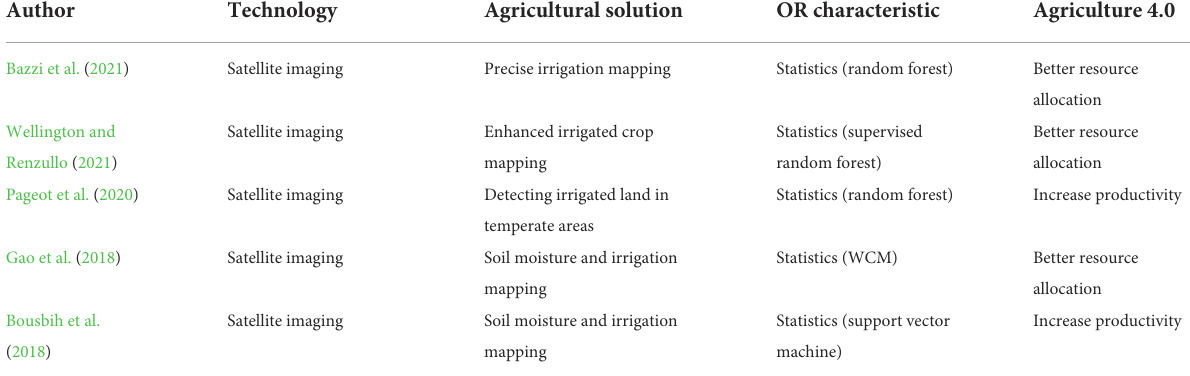
TABLE 9 Research stream: cloud-based satellite for precise irrigation